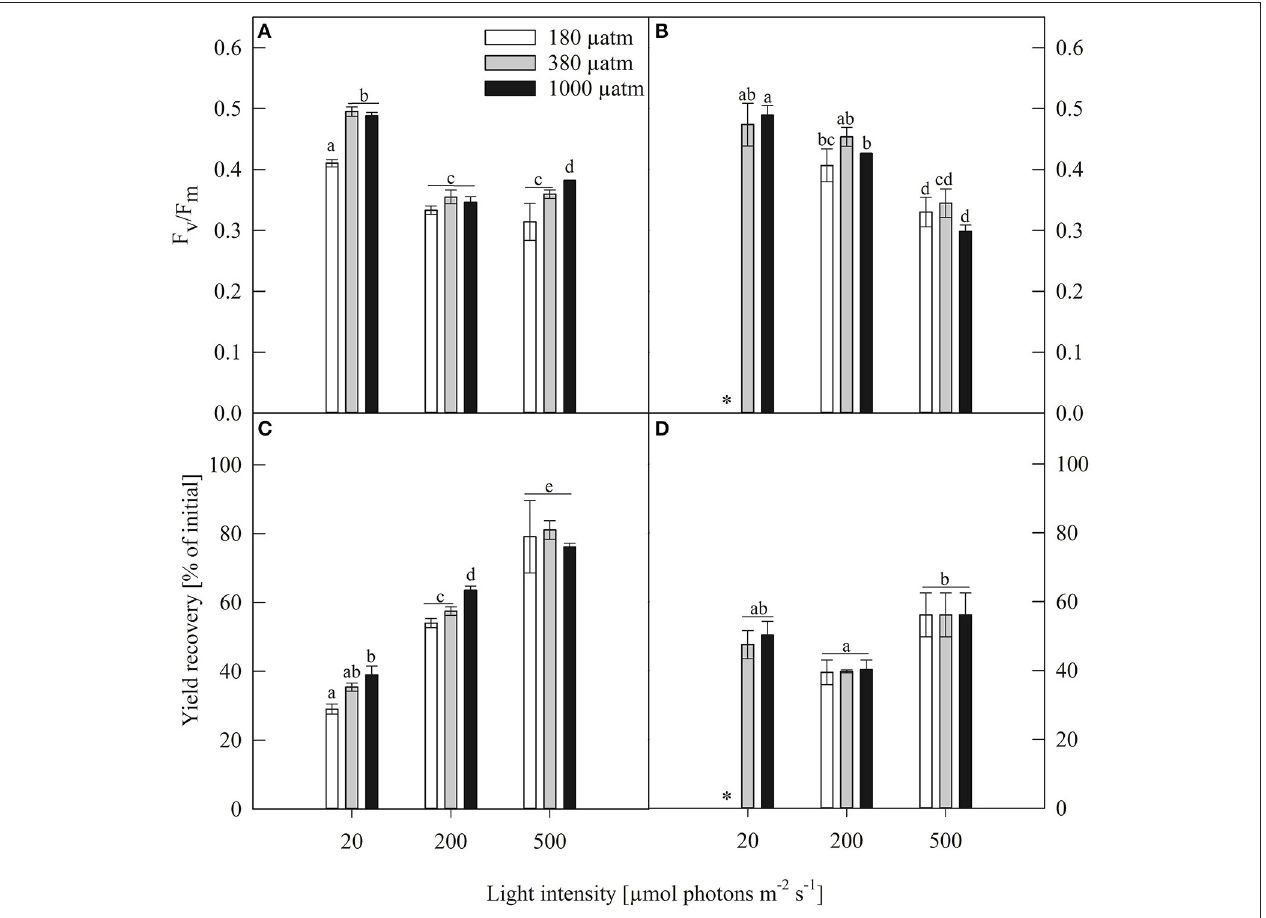
FIGURE 3 | Maximum photosynthetic yield (F v /F m , rel. unit), yield recovery after short term light stress (% of initial) of (A,C) Fragilariopsis and (B,D) Odontella acclimated to different light (LL = 20, ML = 200, HL = 500 µ mol photons m − 2 s − 1 ) and pCO 2 (low = 180, ambient = 380 and high = 1000 µ atm) conditions. Values represent mean ± SE ( n = 3). Odontella did not grow at low light in combination with low pCO 2 as indicated by *. Statistical differences between two treatments ( p = 0.05) derived from post-hoc tests are indicated by different